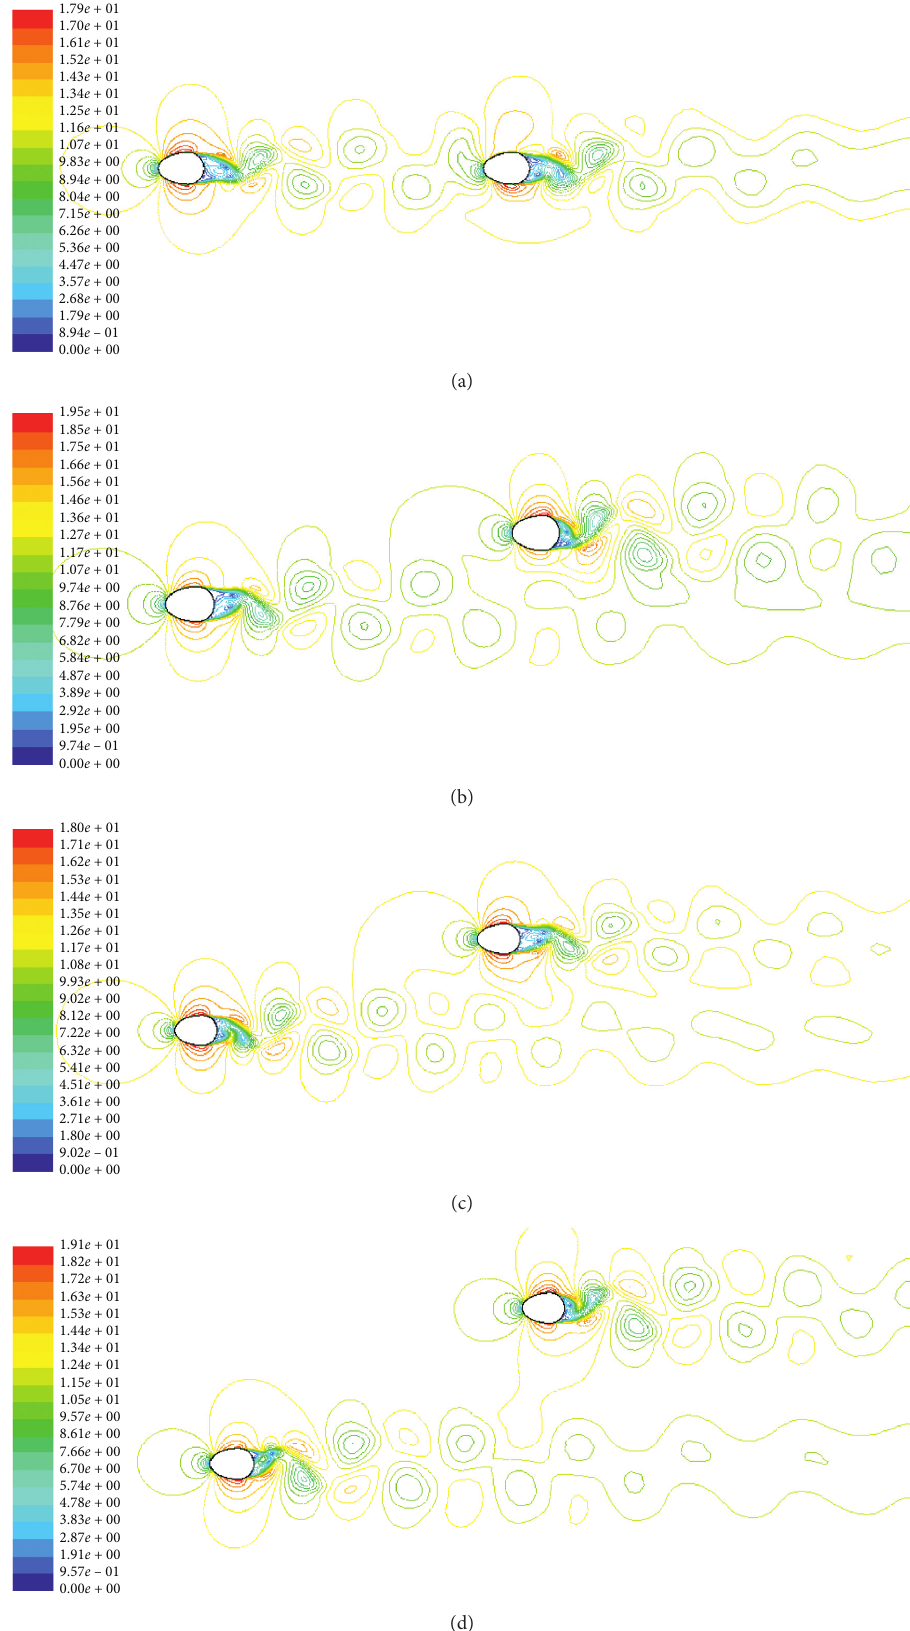
Figure 5: Velocity contours of air flow around an iced twin bundle conductor ( α � 0 ° ): (a) Z � 10 D and Y � 0. (b) Z � 10 D and Y � 2 D . (c) Z � 10 D and Y � 3 D . (d) Z � 10 D and Y � 5 D